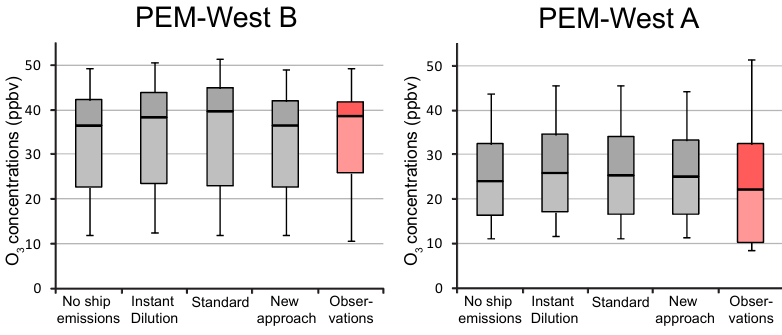
ratio derived NO x